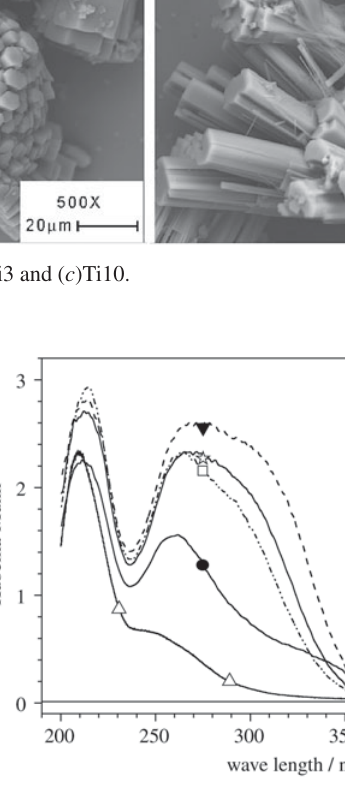
Figure 7. DRS-UV from TAPO-5, with 46 h of crystallization and different Ti contents.